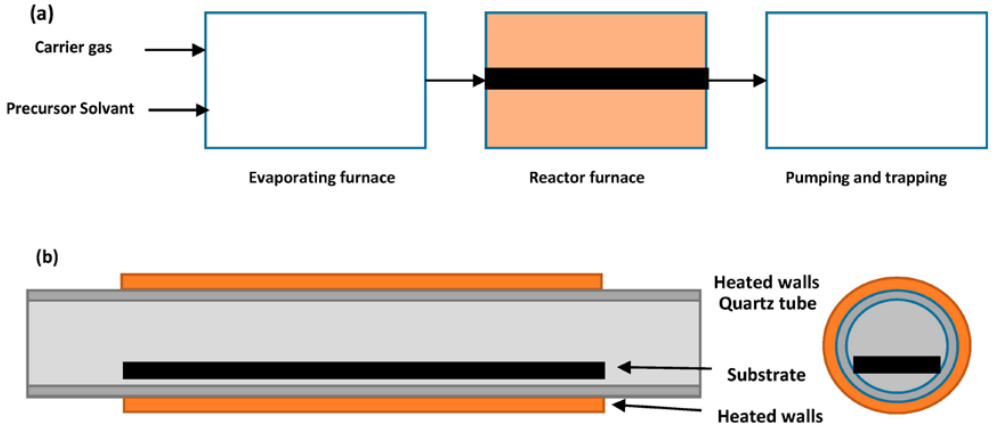
Figure 1. ( a ) Schematic representation of the direct liquid injection metal-organic chemical vapor deposition reactor (direct-pulsed liquid injection–metalorganic chemical vapor deposition (DLI– MOCVD)); the dimensions of the reactor tube are from 0.3 to 1 m; the diameter of the tube is from 8 to 24 mm. ( b ) Schematic representation of the quartz reactor of 24 mm in diameter, 30 cm long, containing a flat substrate of 20 cm.